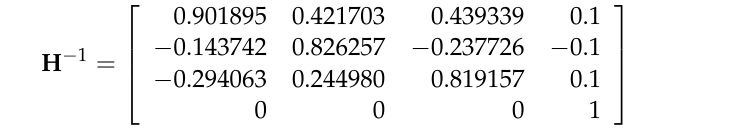
Table 2. Statistical randomization-based particle swarm optimization (SR-PSO) algorithm’s pa- rameters settings in the experiment.